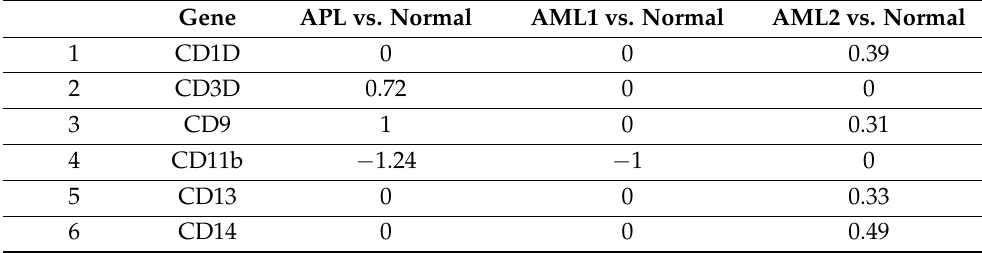
Table 4. The most important differentially expressed CD genes between AML subtypes and normal controls in the microarray dataset. Cohen’s D values are indicated for each dichotomous comparison (group A/left vs. group B/right). Positive values indicate higher expression in group A. Negative values indicate higher expression in group B. Values < 0.7 were set to 0. Gene APL vs. Normal AML1 vs. Normal AML2 vs.